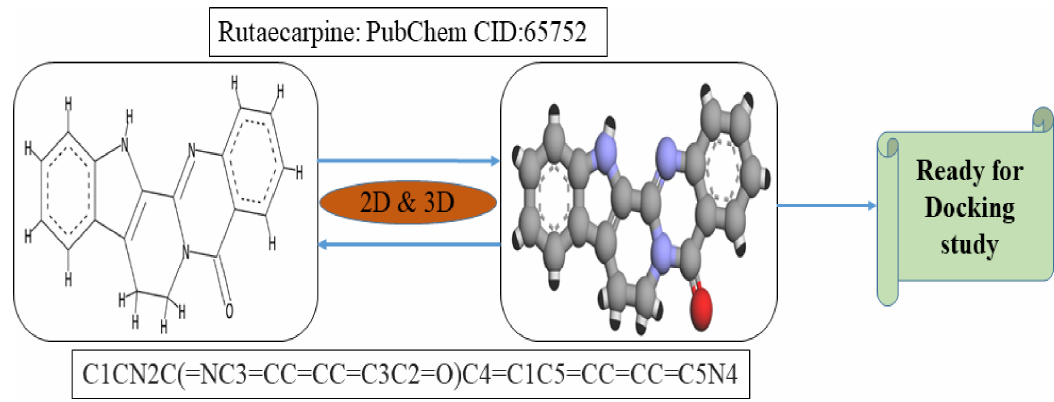
Figure 7. 2D and 3D representations of the rutaecarpine molecule.